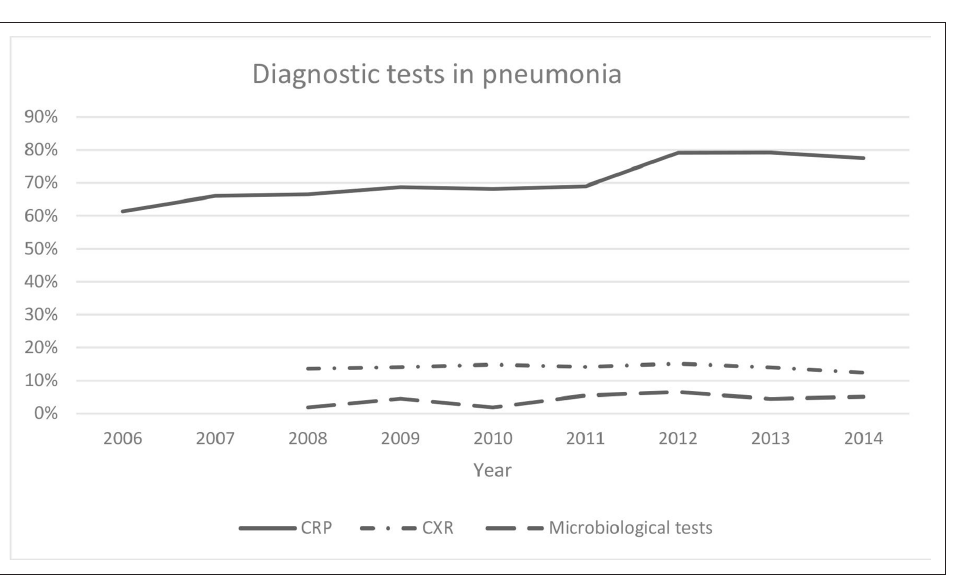
Figure 2 Proportion of patients aged 18–79 years with pneumonia in primary care, where C- reactive protein (CRP), chest x- ray (CXR), or microbiological tests were used in the diagnostic process. Data for CXR and microbiological tests was not available for 2006 and